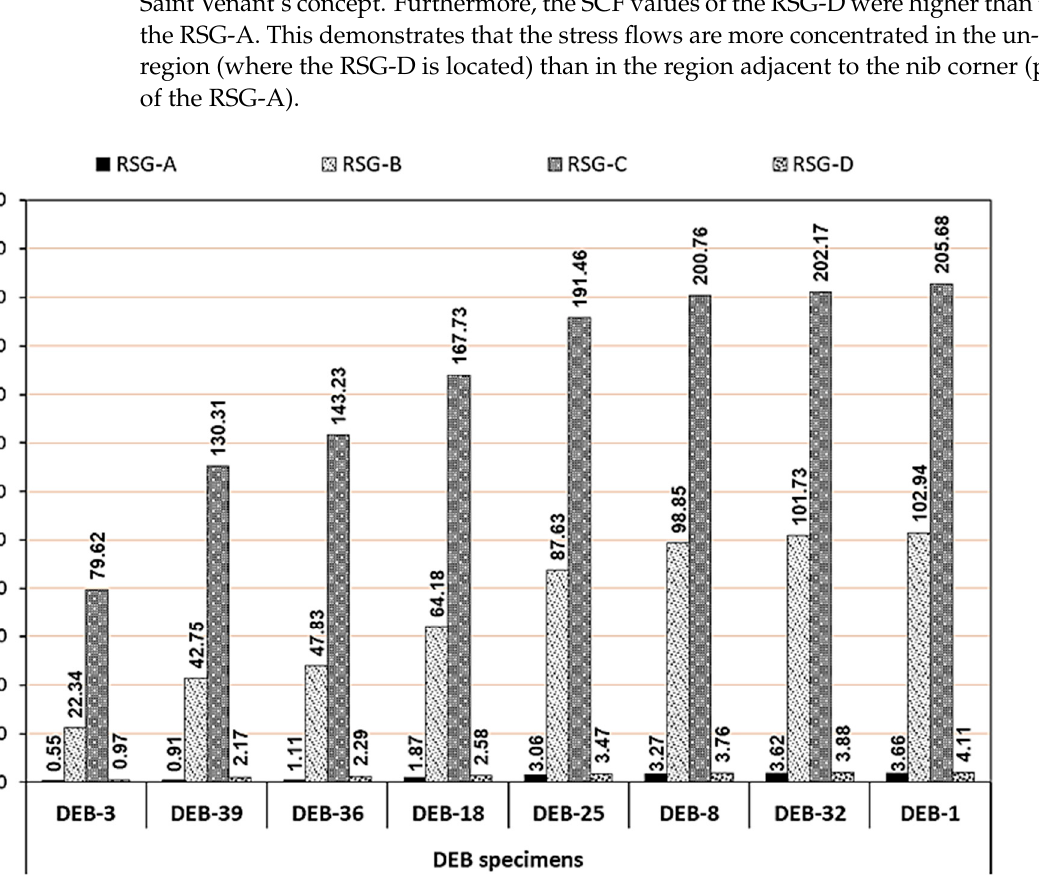
Table 7. The stresses and SCF of RC-DEBs based on RSG-D data. No. DEB No. DEB